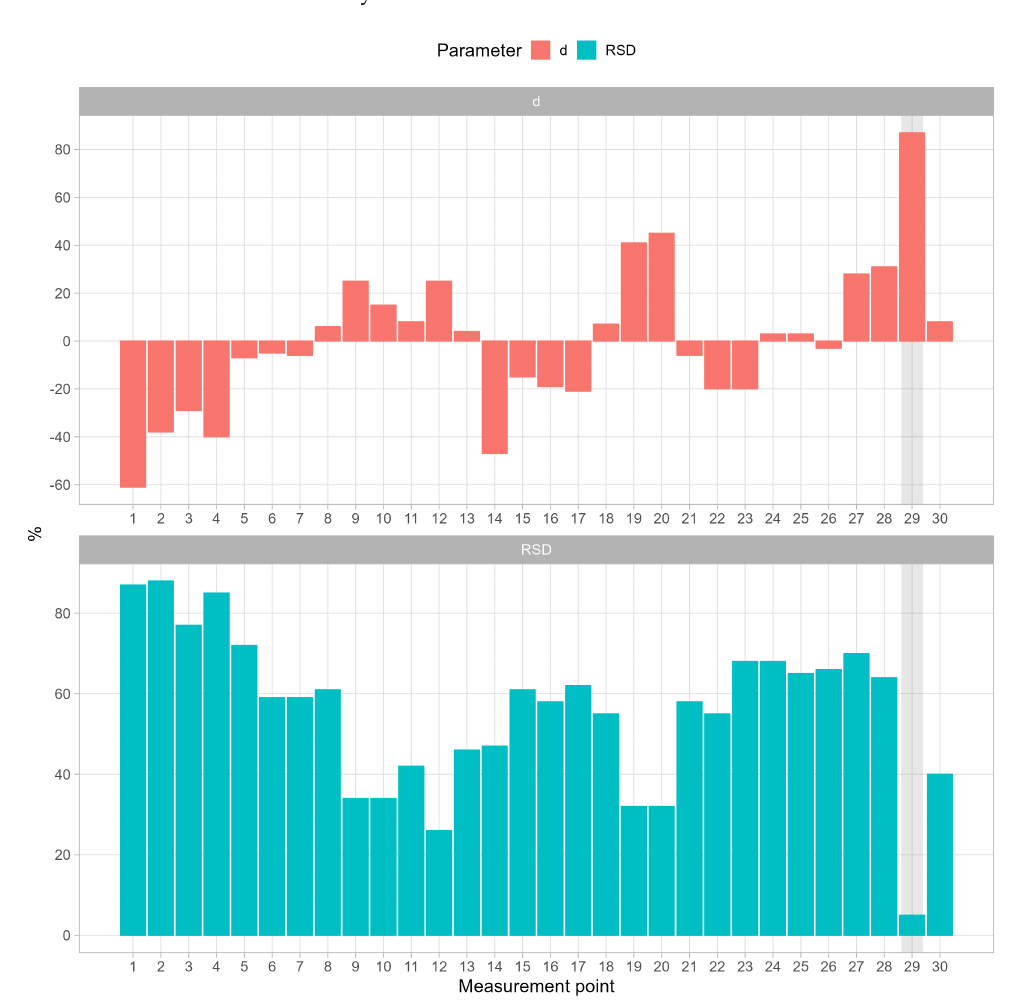
Figure 5. Deviation (d) from the total average radon activity concentration ( top ) and relative standard deviation (RSD) defined as the ratio between standard deviation and average radon concentration for each measurement point ( bottom